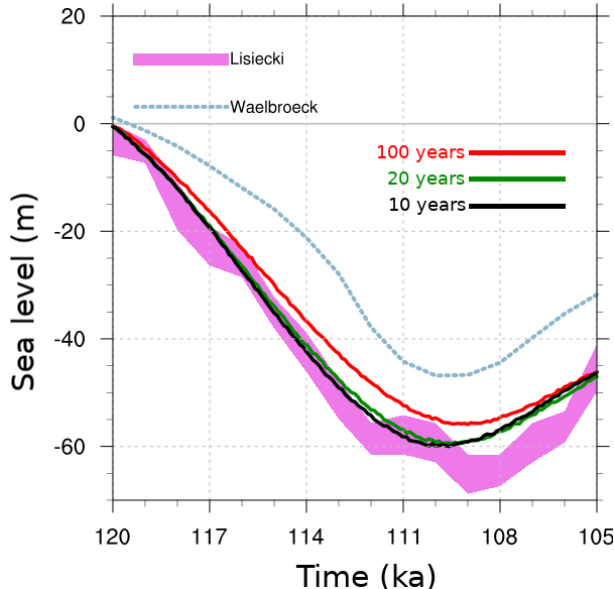
inception, synchronously coupled with 100-year, 20-year, and 10- year time